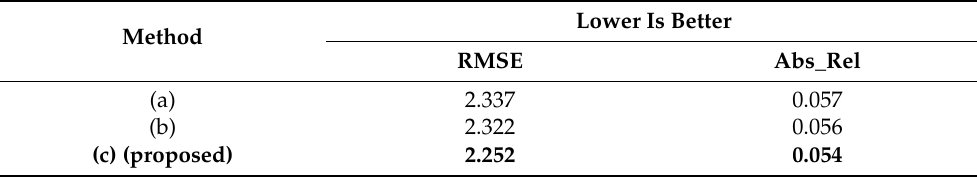
Figure 8. Various structures according to the change of the last layer of the decoder. From left to right: ( a ) add all estimated depth maps with the estimated depth map. ( b ) Concatenate all depth maps with the final layer. ( c ) Concatenate D1 with the final layer (proposed). Table 7. KITTI Eigen split validation results according to decoder structure. (a) Sum of all depth maps extracted from each layer. (b) Concatenation of all depth maps extracted from each layer. (c) Concatenate D1 with the final layer (proposed).